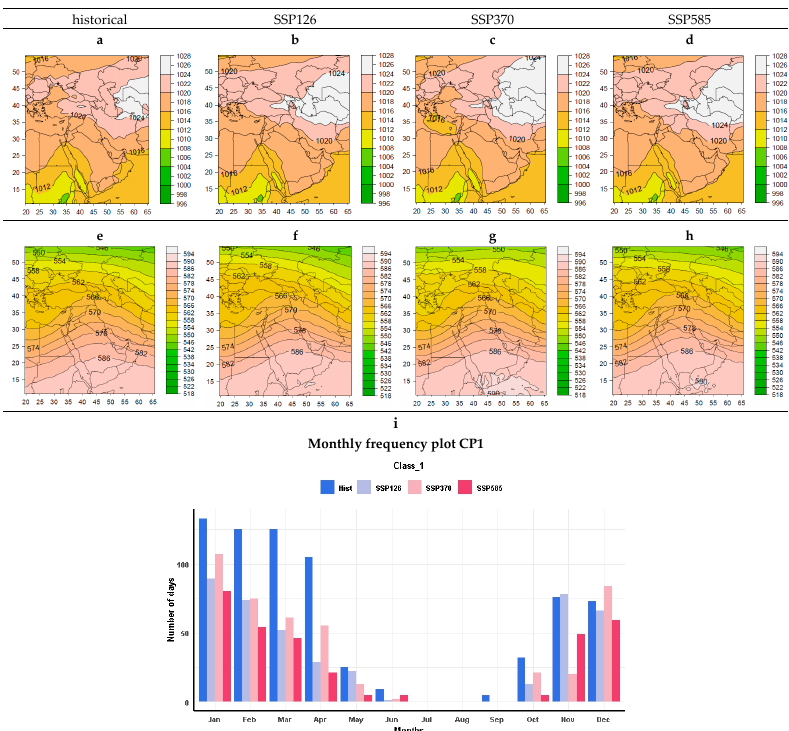
Figure 3. Average sea level pressure (hPa) ( a–d ), average geopotential height of 500 hPa (dam) ( e–h ), and monthly frequency in the period of 1975–2014 (historical) and 2015–2054 (SSP126, SSP370,